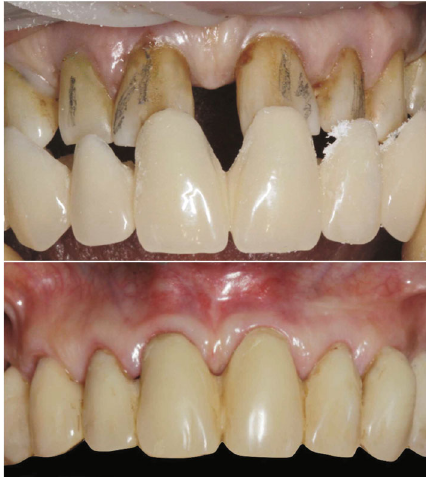
Figure 17: The full-arch interim crown restoration used as a guide for the dental preparation and the correct tooth proportion achieved after BOPT with POA.